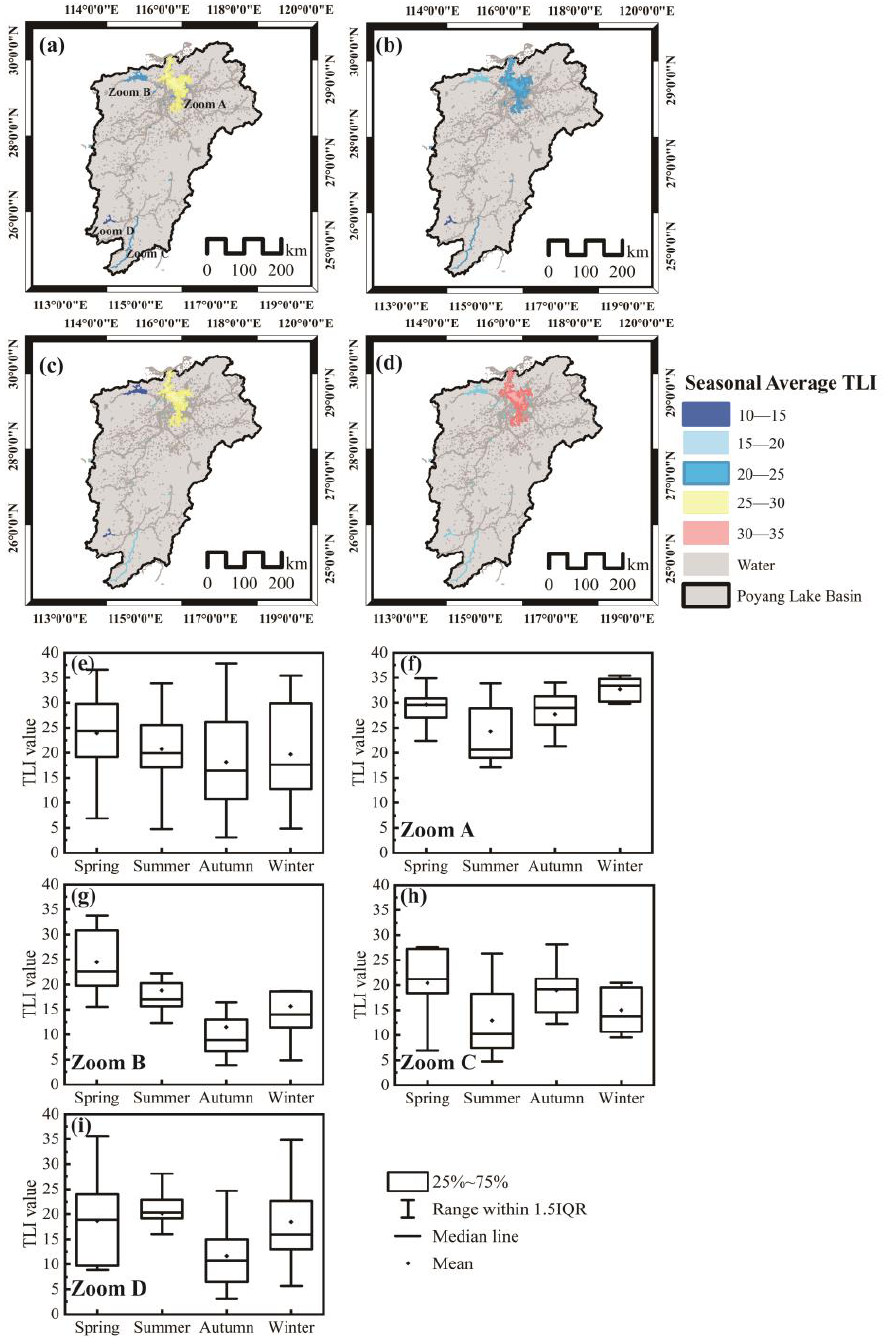
Figure 8. The quarterly mean TLI of these studied regions in the Poyang Lake Basin (( a – d ) represent Quarter 1 to 4) between 2013 to 2020; ( e ) represents the seasonal variation of mean TLI values in Poyang Lake Basin; ( f – i ) represents the seasonal variation of mean TLI values in Poyang Lake, Zhelin Reservoir, Tao Lake and Yangming Lake, respectively.